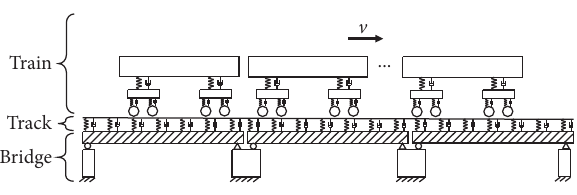
Figure 3: Dynamic model of the train-track-bridge coupled system.